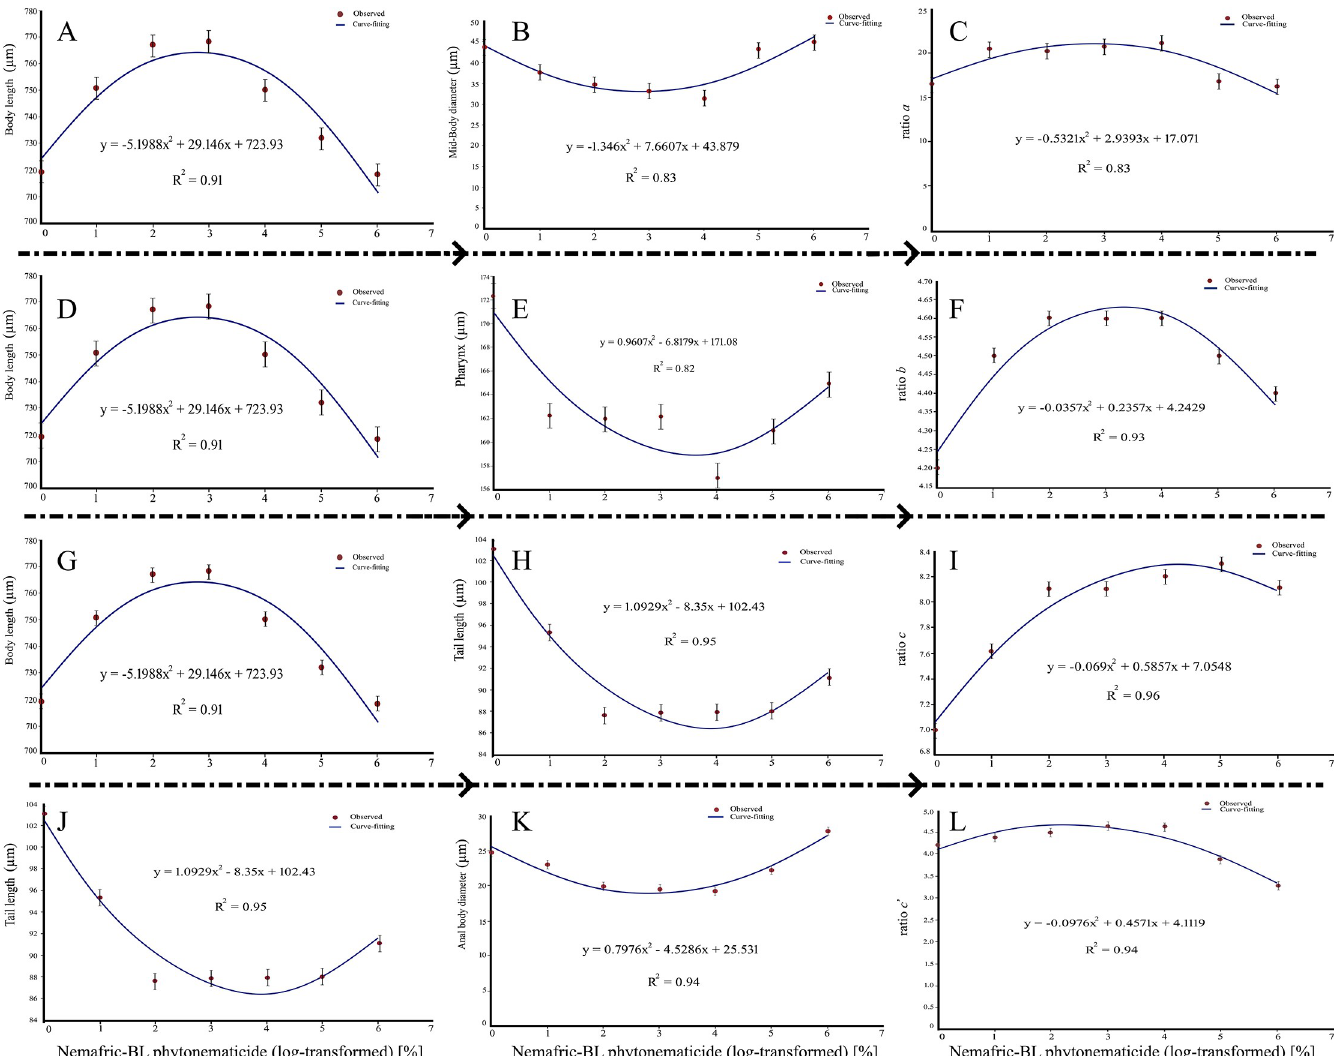
Fig 3. Positive quadratic relations in Steinernema feltiae De Man ratios versus Nemafric-BL phytonematicide: Ratio a (C = A/B) as proportion of body length (A) to mid-body diameter (B), ratio b (E = D/E) as proportion of body length (D) to pharynx length (E), ratio c (I = G/H) as proportion of body length (G) to tail length (H) and ratio c’ (L = J/K) as proportion of tail length (J) to anal body diameter